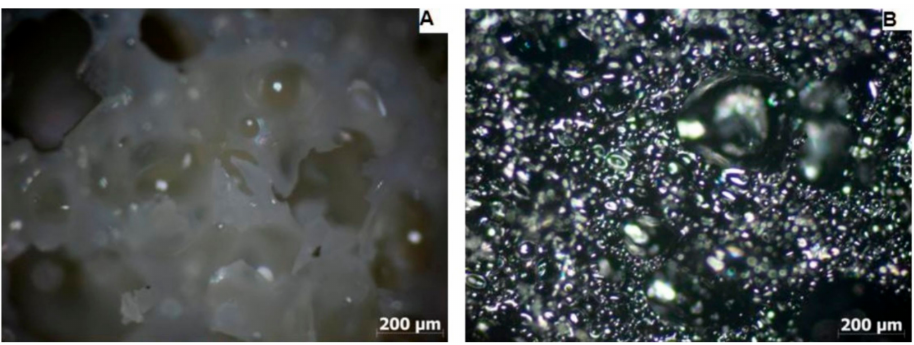
Figure 6. Micrograph of PUR foam ( A ) and carbon foam ( B ) taken with a light microscope-sample